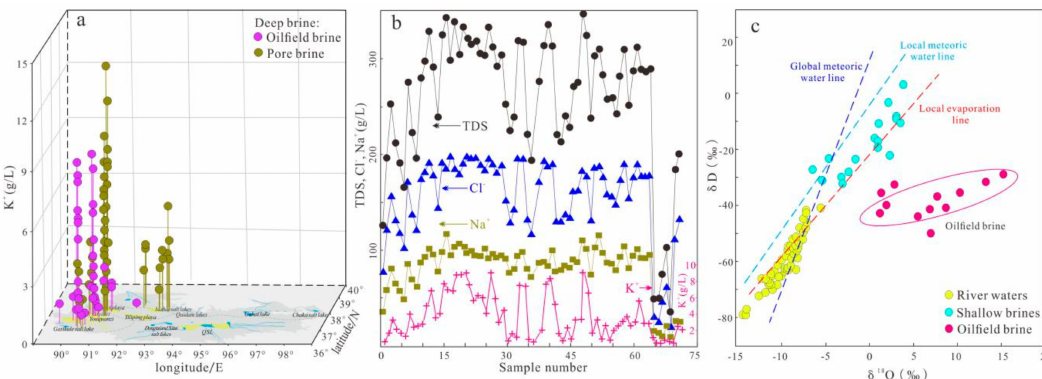
Figure 10. The deep K-rich brines in the QB: ( a ) The K + concentrations and distribution of pore brines and oilfield brines (data from Table S2); ( b ) the consistent variations of K + , Na + , Cl − , and TDS in each pore brine sample indicate that the K has the same source as Na, Cl, and TDS (data from Table S2); ( c ) the δ D and δ 18 O values reveal that the oilfield brines were meteoric water origin, and experienced evaporation and water–rock interaction processes (global meteoric water line is from [56]; local meteoric water line is from [4]; the data of river waters are from [57,58]; data of surface and intercrystalline brines are from [4,15]; data of oilfield brines are from [15,16,19]; the local evaporation line is fitted in this study: δ D = 3.5 × δ 18